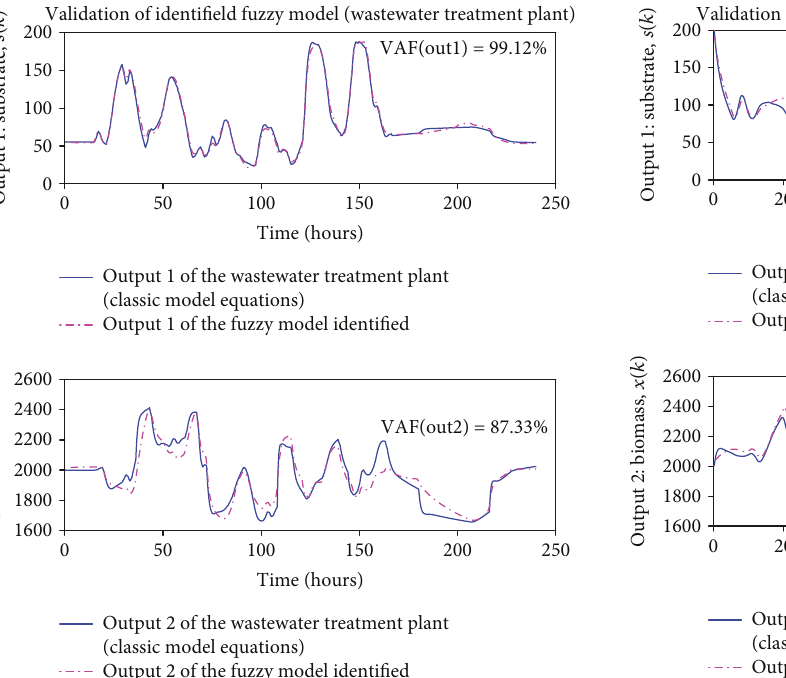
Figure 10: Validation of the identi fi ed fuzzy model corresponding to case D for output 1, s k , and output 2, x k